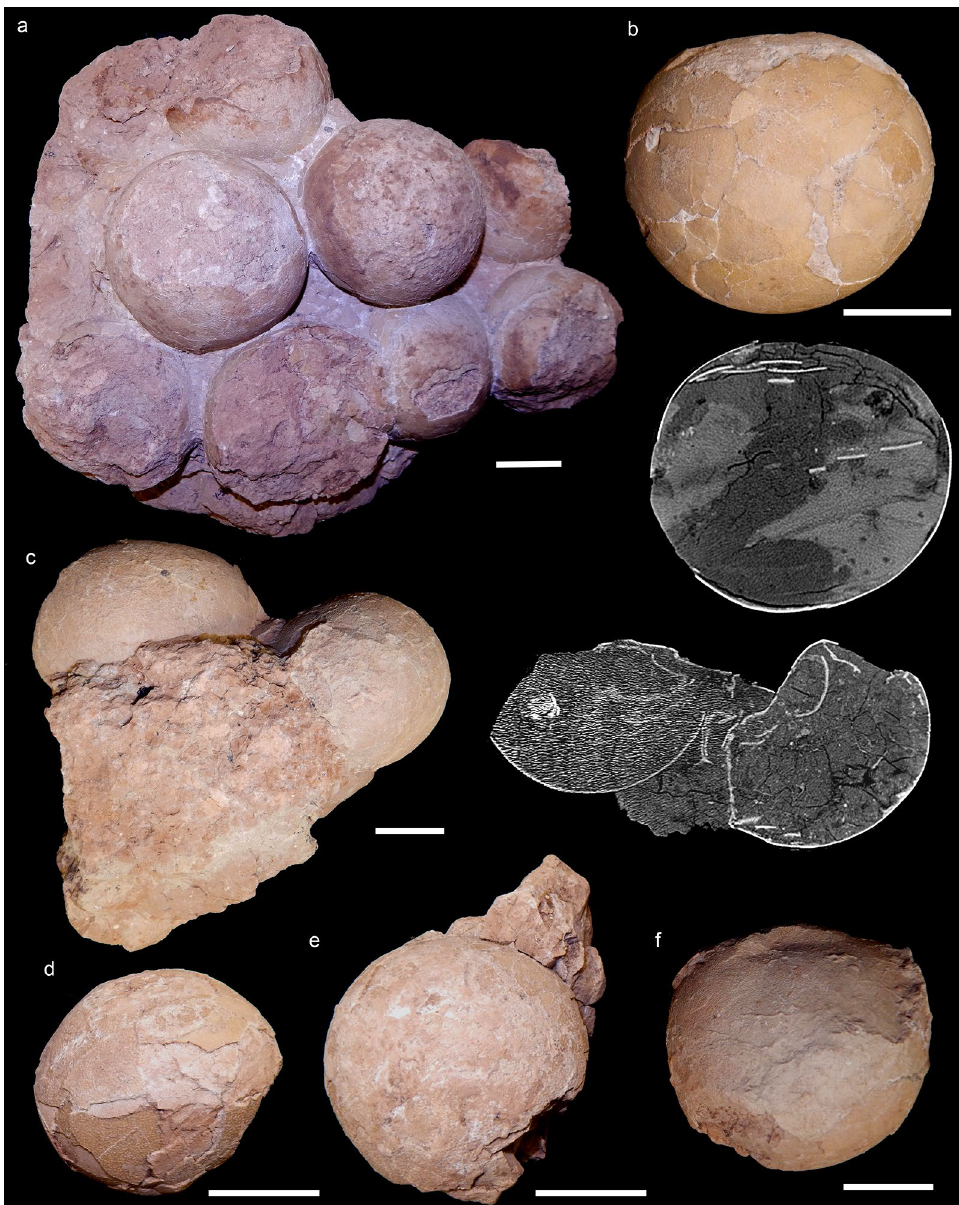
Figure 2. Selected titanosaurian eggs and egg-clutches collected from the Late Cretaceous Serra da Galga Formation (Bauru Group) at Ponto Alta nesting site, Uberaba Municipality, Minas Gerais State, Brazil. ( a ) CPPLIP 1798, best-preserved recovered egg-clutch, bottom view. ( b ) CPPLIP 1801, isolated egg, with accompanying tomographic slice, showing thickness of the shell and its sedimentary fill. ( c ) CPPLIP 1799, egg- clutch with accompanying tomographic slice, showing thickness of the shell, shells collapsed and its sedimentary fill. ( d , e ) CPPLIP 1800, two eggs found associated. ( f ) CPPLIP 1804 isolated partial egg. Scale bars 5